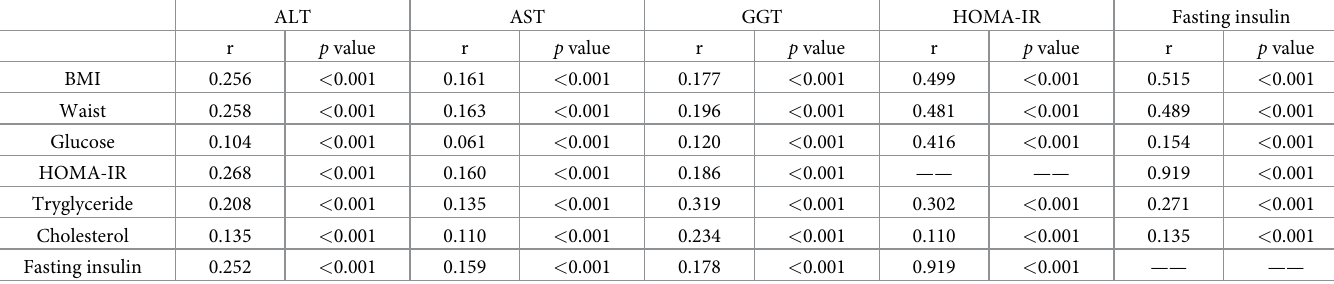
Table 2. Correlation of serum ALT, AST, GGT, HOMA-IR and Fasting Insulin with other variables adjusted for age and sex.